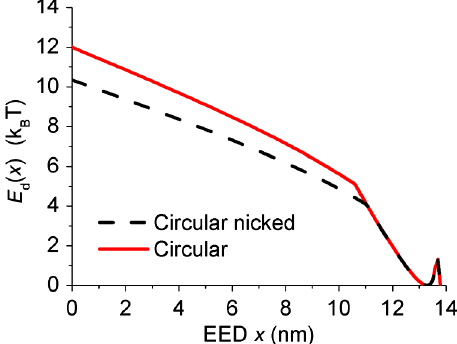
ð x Þ vs EED x FIG. 6. Graph of the ds DNA bending energy E d ¼ 41 (contour length 2 L ¼ 13 : 7 nm ). The from Eq. (3), for N d ¼ 31 : 3 pN (cid:1) nm (corresponding to solid line is the plot for (cid:1) c ¼ 27 : 0 pN (cid:1) nm (corre- the intact DNA); the dashed line is (cid:1) c sponding to the nicked DNA); B ¼ 50 kT (cid:1) nm in both cases. The zero-force EED is slightly smaller than the contour length 2 L because of thermal fluctuations [included in Eq. (3)]; the (cid:6) 5 kT , WLC energy (steep part of the curve, for 0 (cid:6) E d approximately) is approximately linear in EED x ; the kinked state energy ( 5 kT (cid:6) E d (cid:6) 12 kT , approximately) is also ap- proximately linear in EED x , but with a smaller slope. For these short molecules, most of the parameter space (in x ) corresponds to the nonlinear elasticity (kinked)